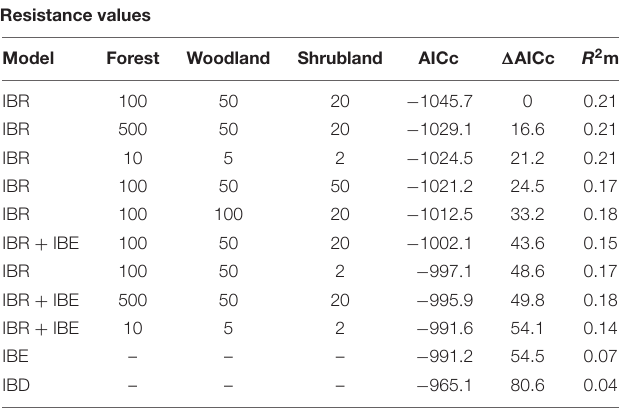
TABLE 3 | Maximum likelihood of population effects (MLPE) models relating pairwise F ST to pairwise distance matrices of isolation by resistance (IBR), isolation by environment (IBE), and isolation by distance (IBD) and ranked by